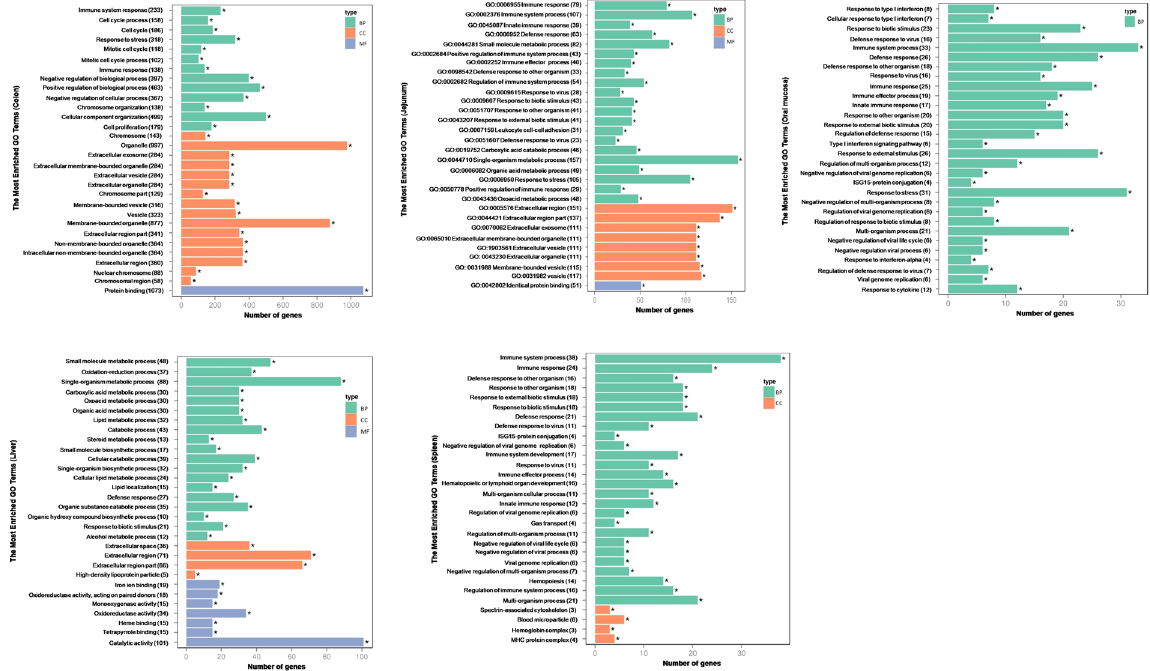
Figure 2. The most enriched Gene Ontology (GO) terms in the colon, jejunum, oral mucosa, liver and spleen. BP: biological process, CC: cellular component, MF: molecular